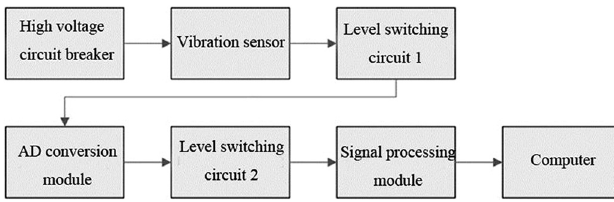
Fig. 3. Structure diagram of fault circuit breaker detection.